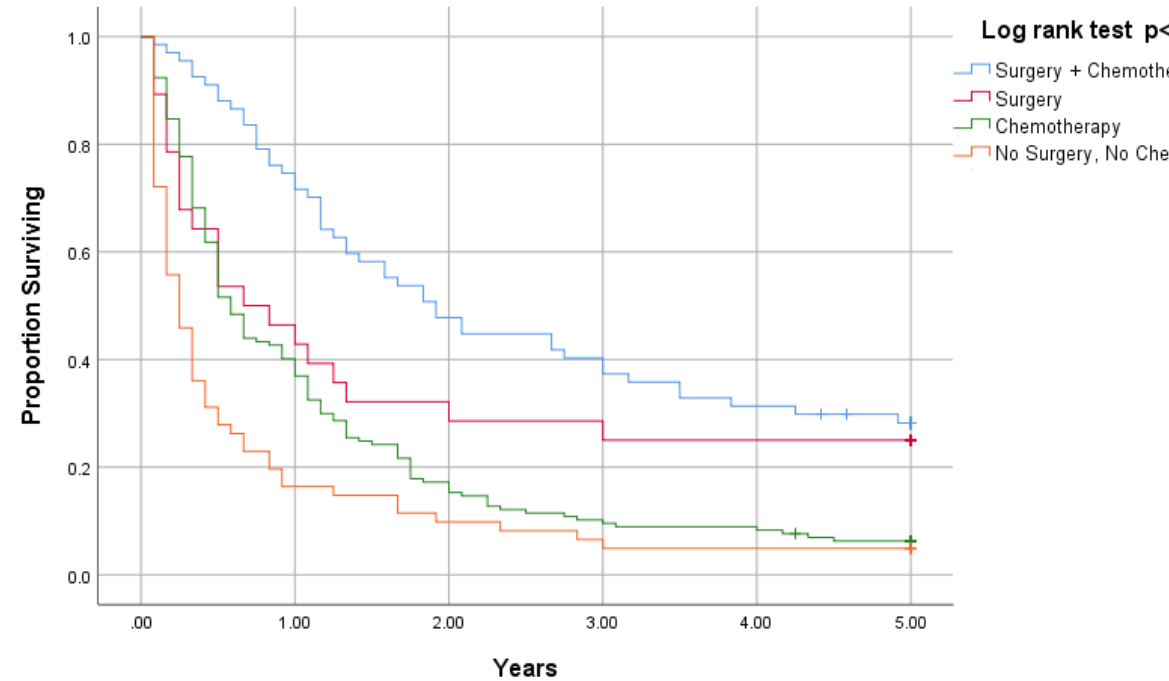
Figure 2. Kaplan–Meier curves among patients with malignant pleural mesothelioma by treatment methods.